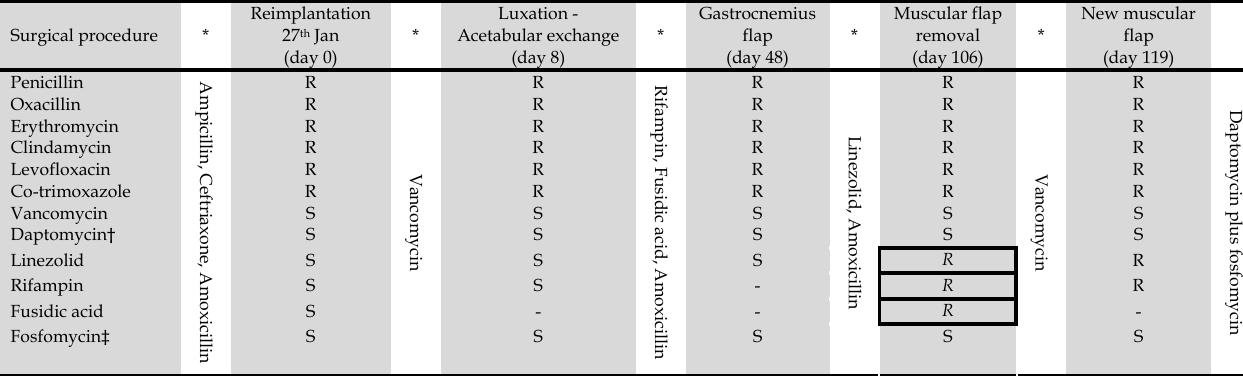
Table 1 . Antimicrobial susceptibility profile over time of Staphylococcus epidermidis Surgical procedure